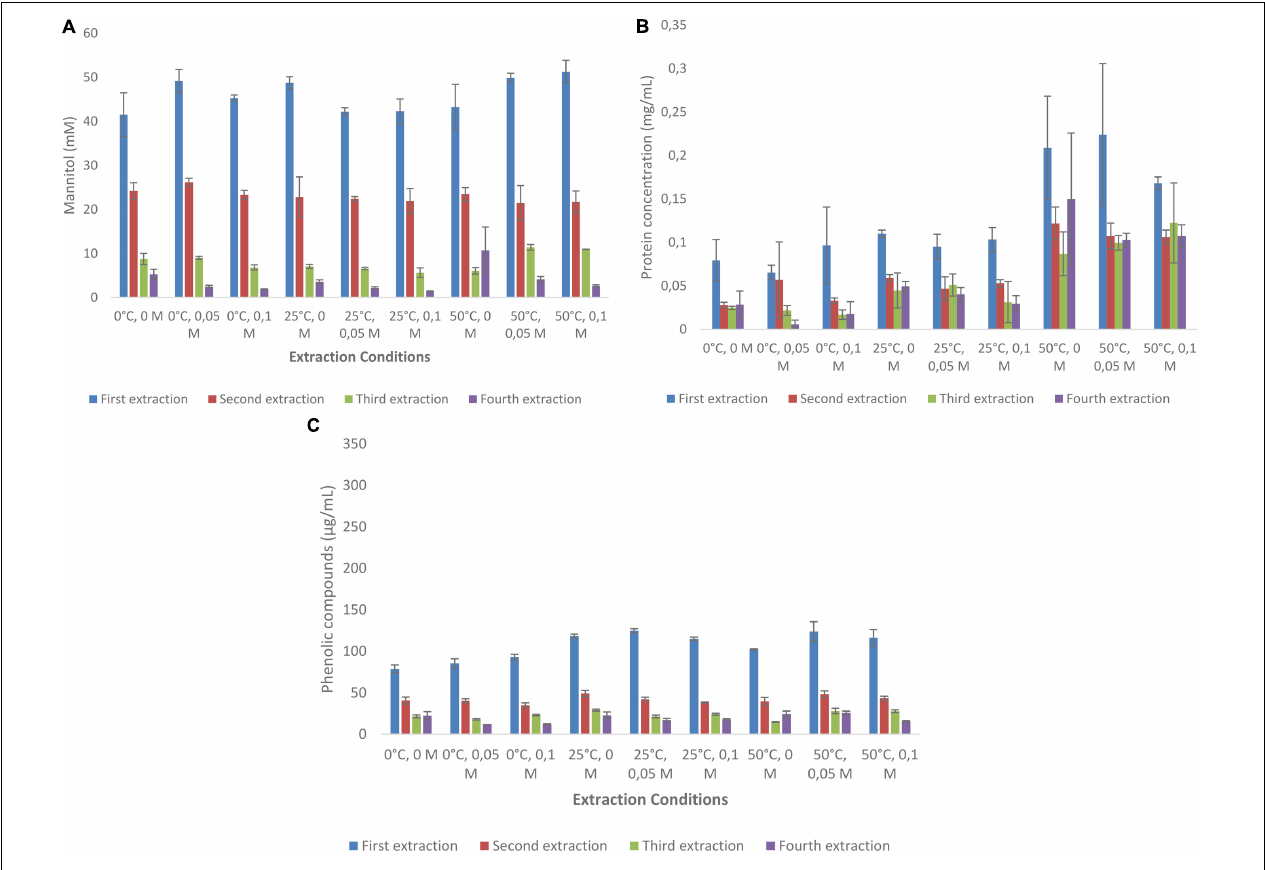
FIGURE 2 | Sequential solid-liquid extraction of mannitol from Laminaria digitata at various temperature and HCl concentrations. (A) Mannitol concentration, (B) protein concentration, (C) total phenolic compounds as gallic acid equivalent.